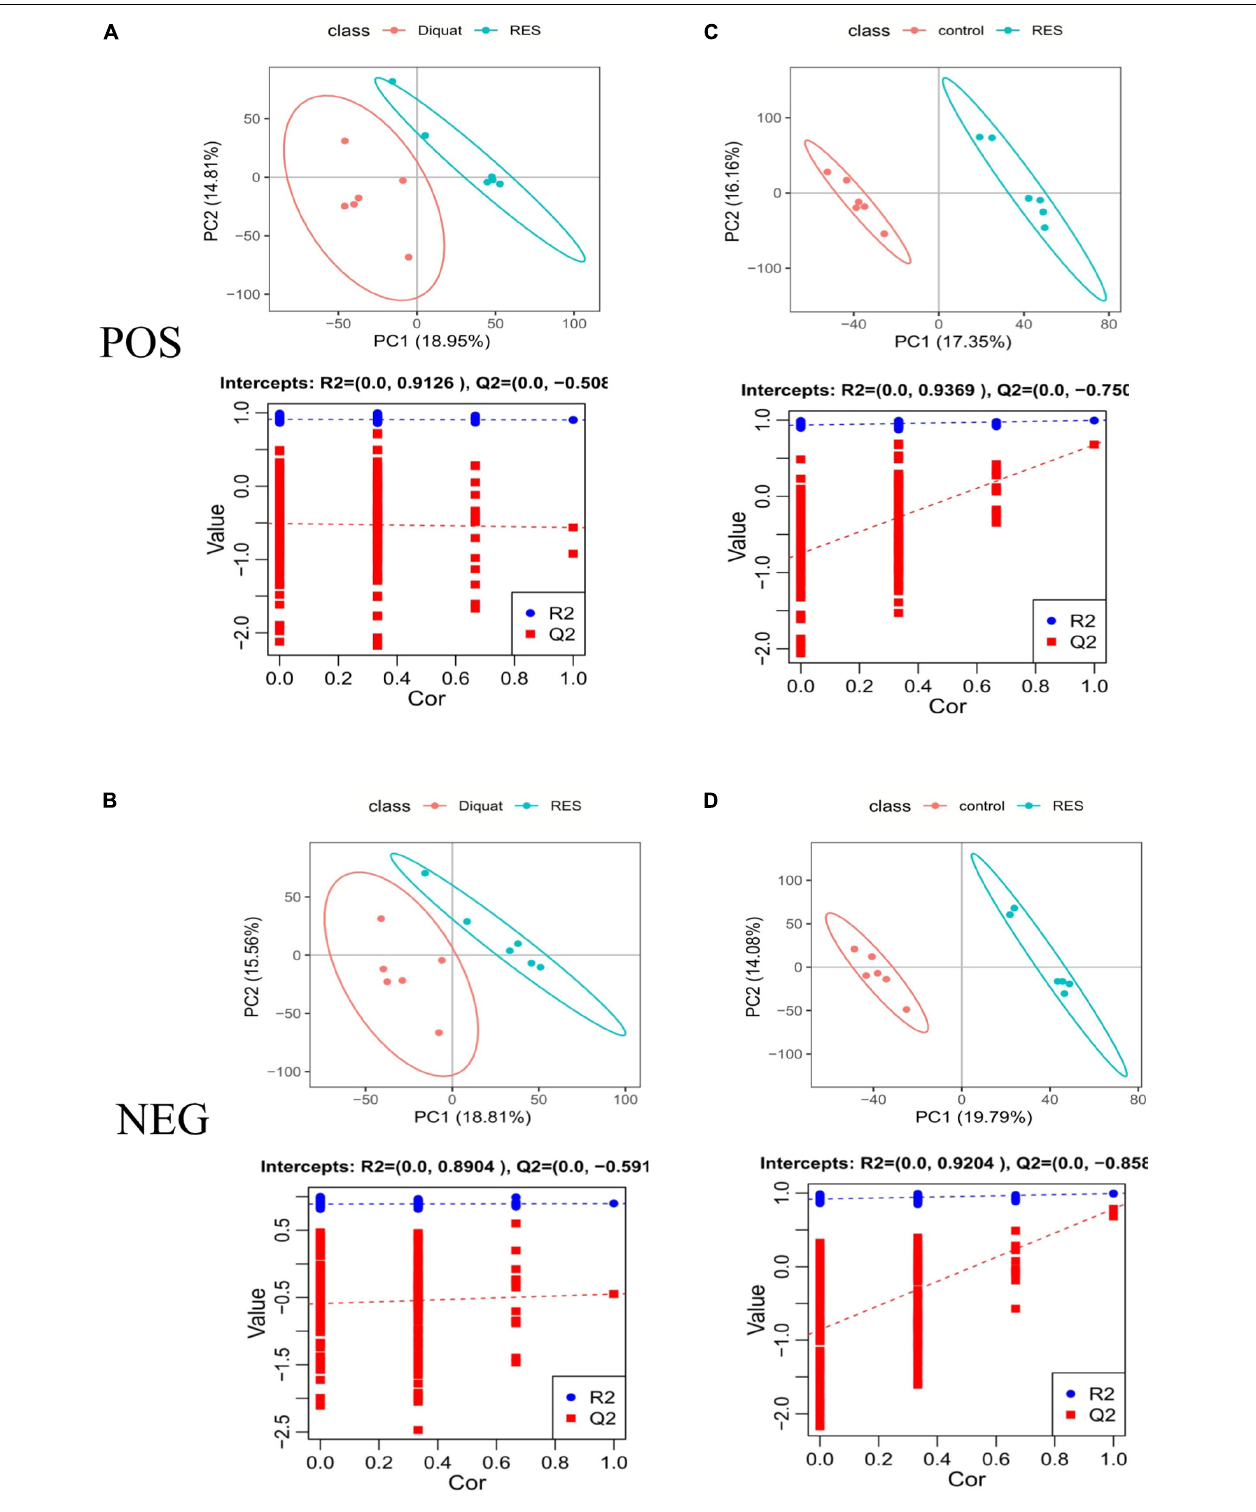
FIGURE 5 | Positive model (A,C) and negative model (B,D) . PLS-DA scores: The abscissa represents the first principal component PC1, and the ordinate represents the second principal component PC2. Replacement test diagram: R2 stands for model verification, and the Y matrix of original classification and N times of different arrangement are linearly regressed with R2Y and Q2Y, and the intercept values of regression line and y -axis are R2 and Q2, respectively; used to measure whether the model is over-fitted.